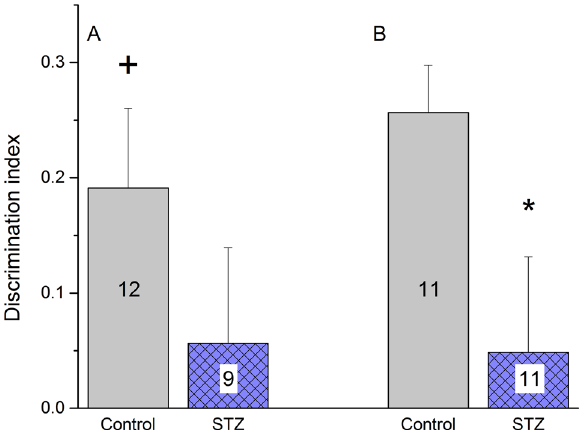
Figure 5. Novel object recognition performance of icv. STZ-injected (‘STZ’) and vehicle treated (‘control’) rats at Week 11 post-injection. Columns show means ± SEM values of discrimination index. Numbers inside the columns indicate the number of animals. ( A ) Results of old animals. + : p < 0.05 vs zero, singe sample t-test, control: t(11) = 2.76, STZ: t(8) = 0.67, ns.), effect size: 0.55.Three animals in the STZ group died before the test